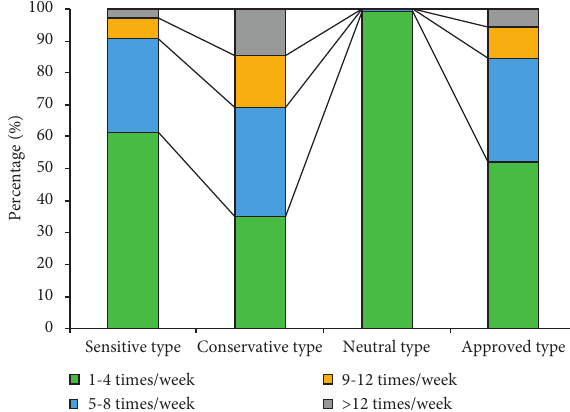
Figure 13: Driving frequency of drivers in the four